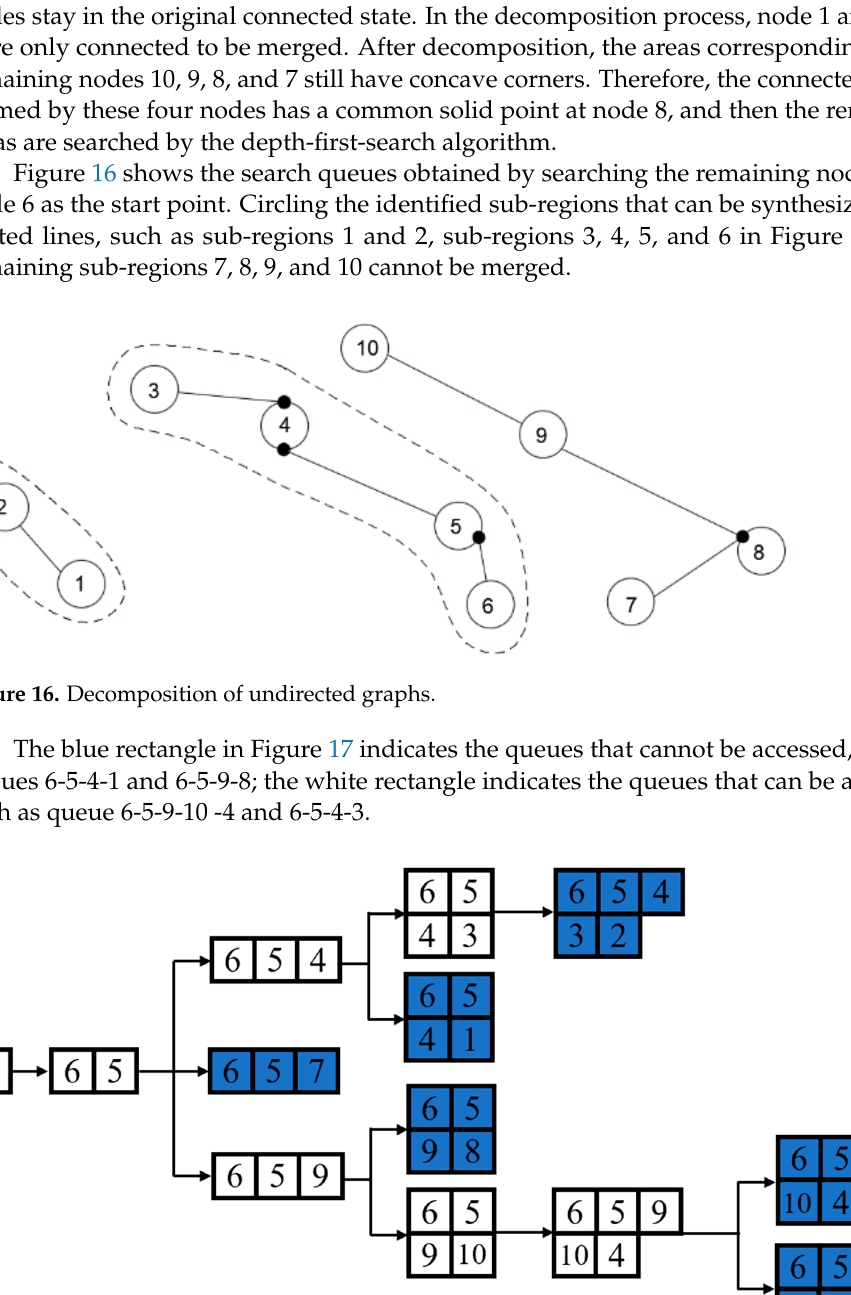
Figure 17. Schematic diagram of a search queue starting from node 6.